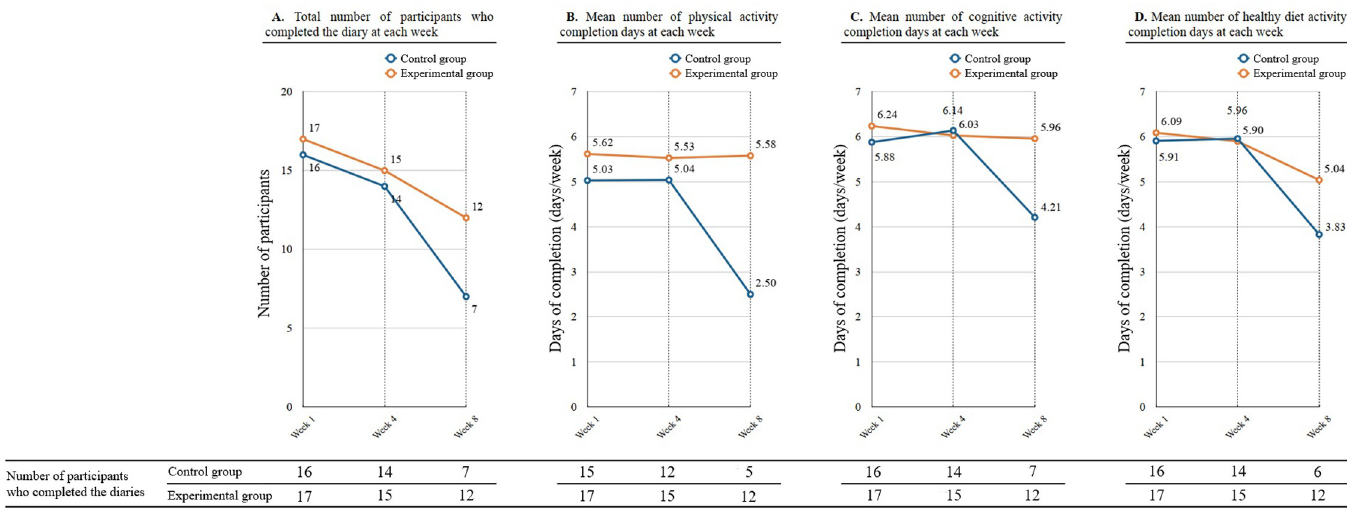
Fig 2. Activity completion recorded on daily diaries: Physical, cognitive, and healthy